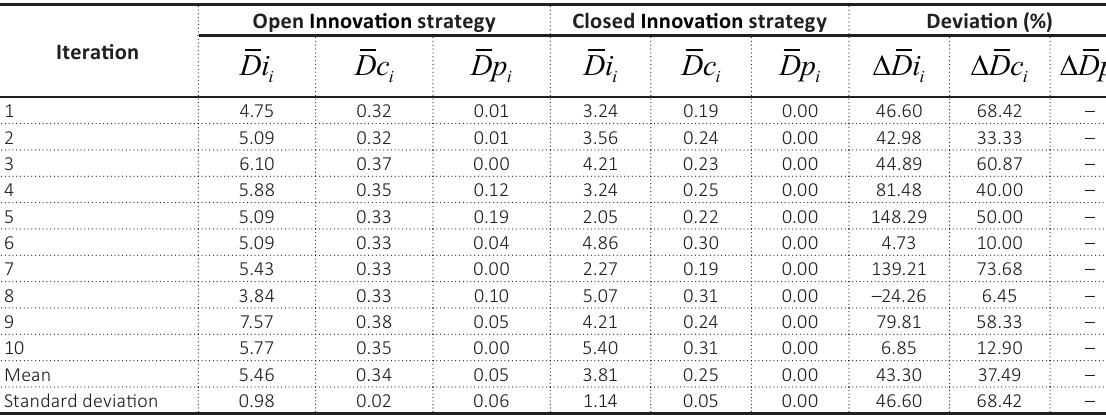
Table 2. Criteria for the effectiveness of organizational structure of 10 subjects (actors, agents) of healthcare institutions from the standpoint of the Open Innovation or Closed Innovation cooperation